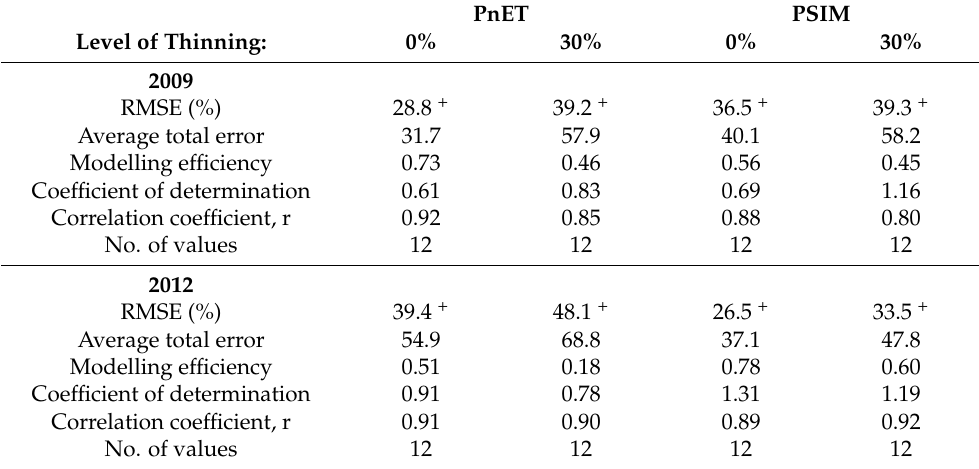
Table 7. Results from ModEval statistical analysis [46] of monthly TER data for 2009 and 2012 simulated with PnET and PSIM and compared with eddy covariance measurements at the Straits Inclosure. Results from modelling with 0% thin are compared with measurements from the western, unthinned sector and those from modelling with 30% thin are compared with the eastern, thinned sector (EC data from [45]). PnET PSIM Level of Thinning: 0% 30%